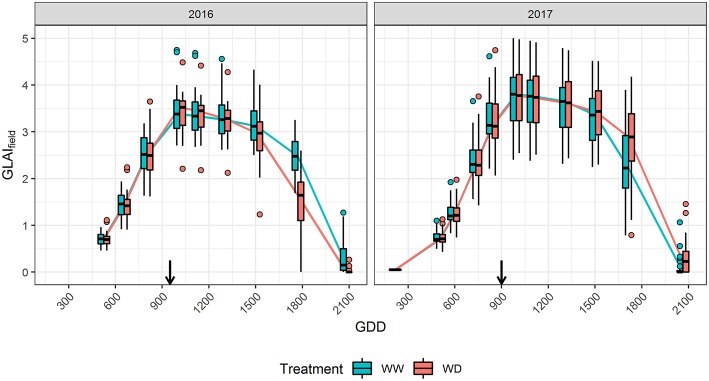
Effect of drought stress on GLAIfield dynamics in 2016 and 2017. Boxplots are built from the reference microplots data for each flight date. The horizontal line in the boxplots corresponds to the median, while the diamond corresponds to the mean. The lower and upper hinges show the first and third quartiles, and the whiskers correspond to 1.5 times the inter-quartile range or to the most extreme value, whichever is smallest. Dots represents values outside this range. Black arrows indicate flowering time.